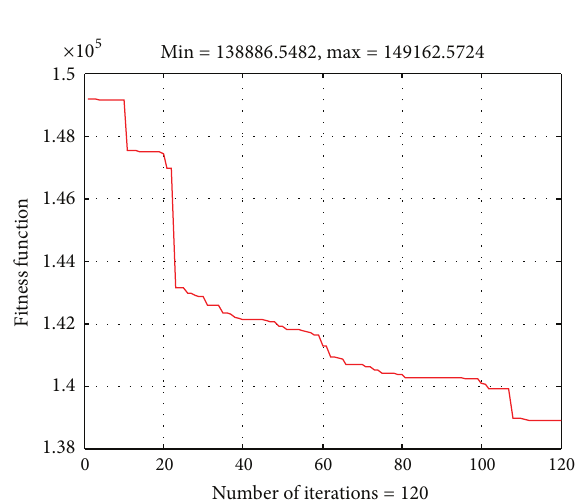
Figure 5: Convergence characteristic of the ABC algorithm for the IEEE 118-bus